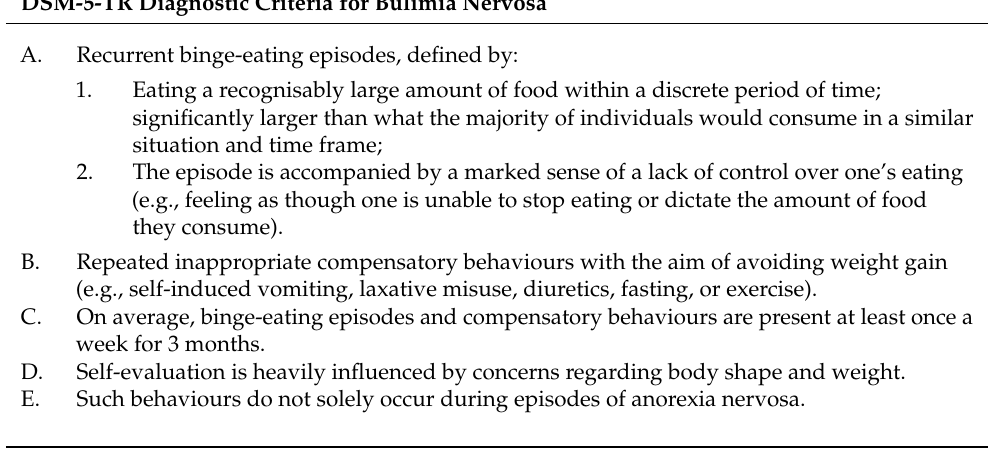
Table 1. Diagnostic Criteria for Bulimia Nervosa derived from DSM-5-TR. DSM-5-TR Diagnostic Criteria for Bulimia